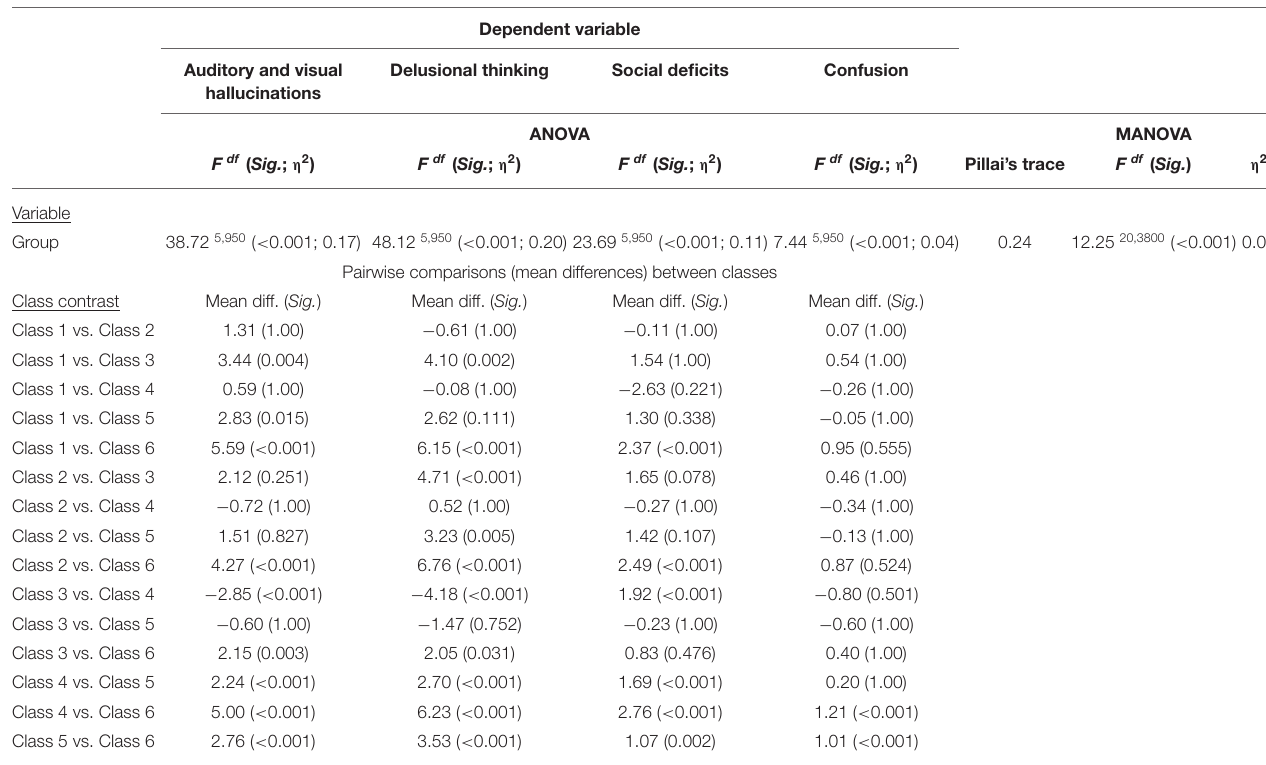
TABLE 5 | The effects of group (latent profile) in relation to Reality Testing